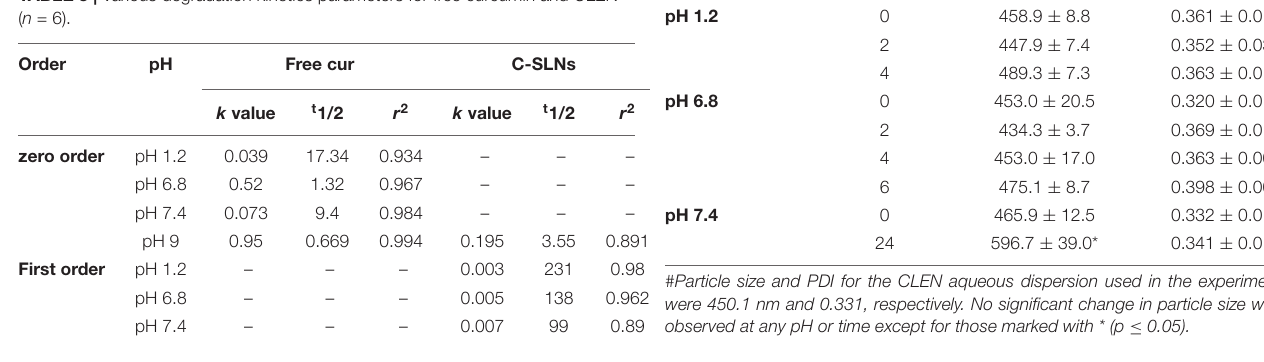
In vitro Release